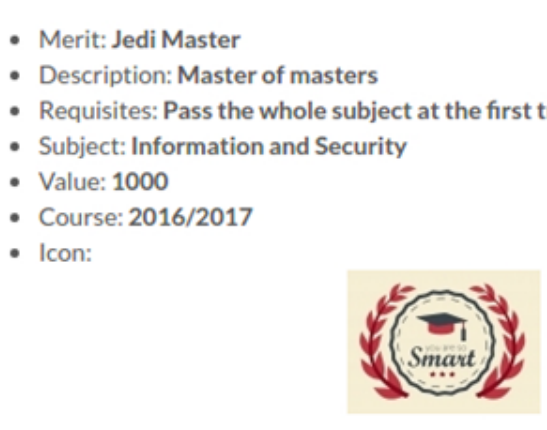
Figure 1. Detail of one of the merits from the subject “Information and